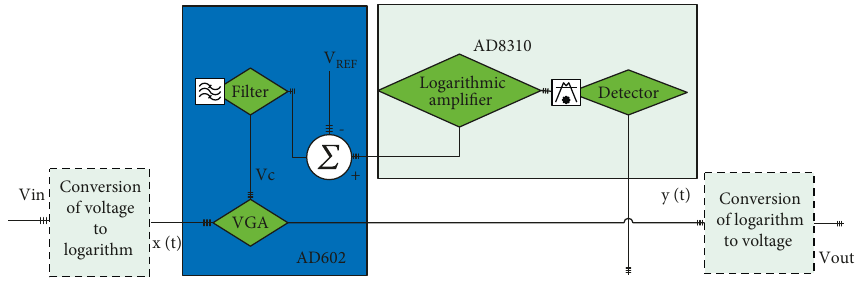
Figure 11: 80dB dynamic range AGC design block